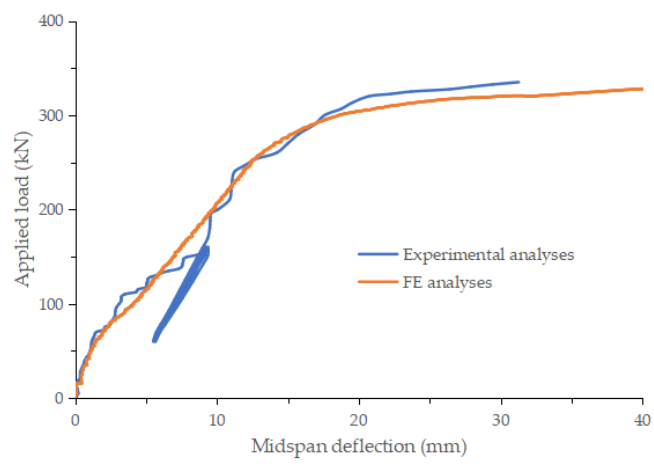
Figure 9. Load-displacement curve for a UHPC layer ratio of 0.